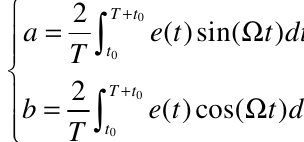
Figure 11. The simplified control diagram and its transformation of the MLR.